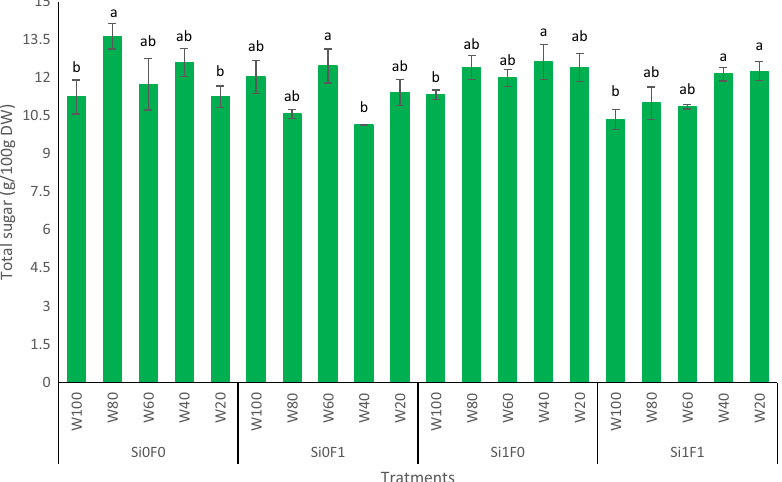
Figure 1. Total sugar content of licorice root under drought stress integrated by silicon nutrition and mycorrhiza inoculation. According to the analysis of variance that triple effects of fungi, drought levels and Si showed significant difference, slice method used for mean comparisons. Mean values with the same letters are not significantly different ( p < 0.05), Tukey test. W stands for water deficit treatment (5 levels including 100% (W100), 80% (W80), 60% (W60), 40% (W40), and 20% (W20) of field capacity), Si stands for silicon application (two levels including Si0 (no Si application) and Si1 (Si application)) and F stands for mycorrhiza inoculation (two levels including F0 (no inoculation) and F1